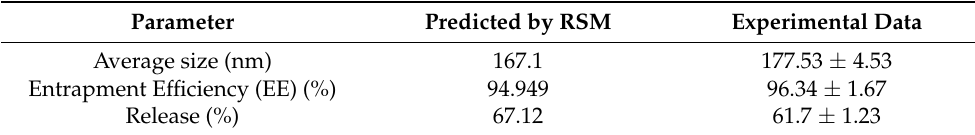
Table 8. The optimized responses were attained by the Box–Behnken method and the empirical data for the similar reactions under optimum